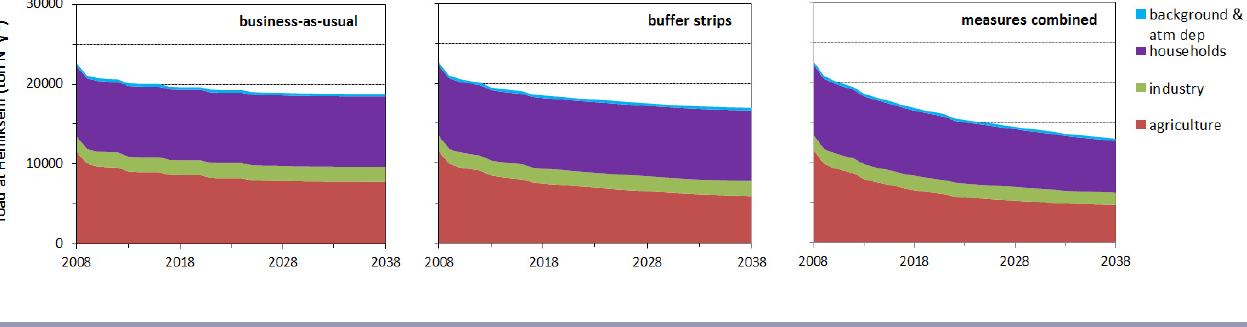
Fig. 7. Apportionment of the nitrogen load of the Scheldt at Hemiksem to different sectoral sources in three scenarios: business as usual, buffer strips, and options (2) to (5) combined. These three scenarios span the total range in outcomes of all scenarios (Fig.